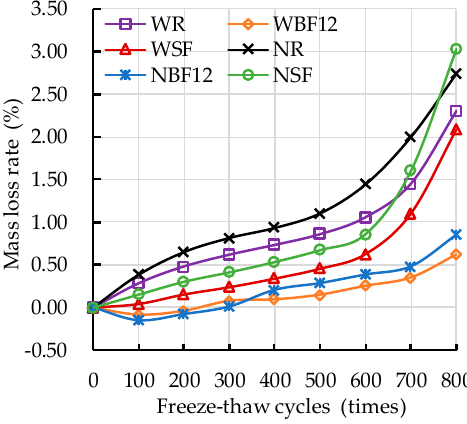
Figure 8. Mass loss versus freeze – thaw cycles.